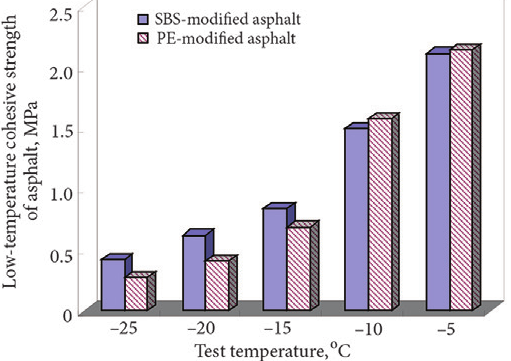
Figure 8. Change law of the two types of bitumen low-temperature cohesive strength after ageing for 48 h